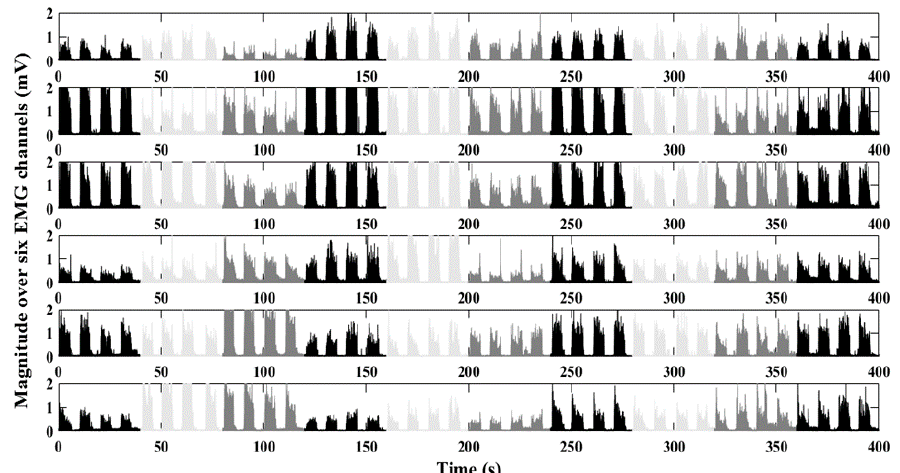
Figure 2. Rectified EMG recorded from the six surface electrode systems in a trial of an intact-limb subject. Six iEMG channels were also recorded concurrently (not shown). Eleven movements (including rest) were repeated four times with a contraction and relaxation time of five seconds. A group of four with the same gray level represents the four repetitions of the same movement.